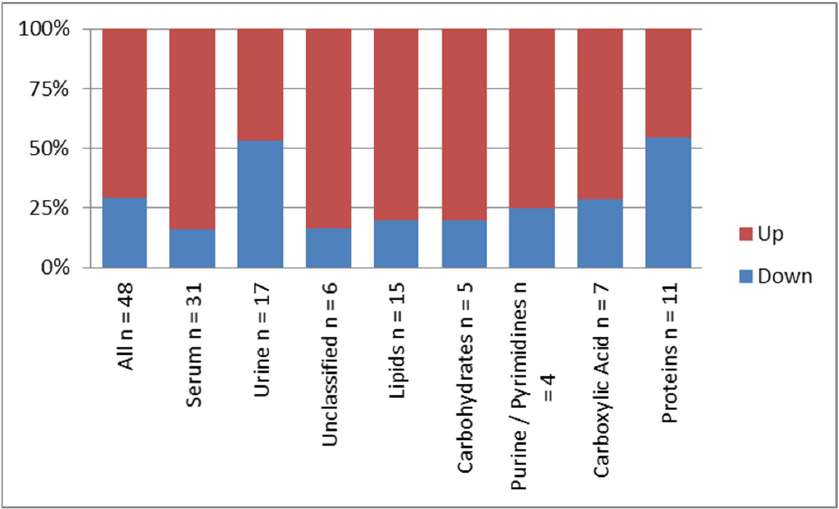
Figure 2. Pattern of regulation of identified metabolites based on biofluid and class of